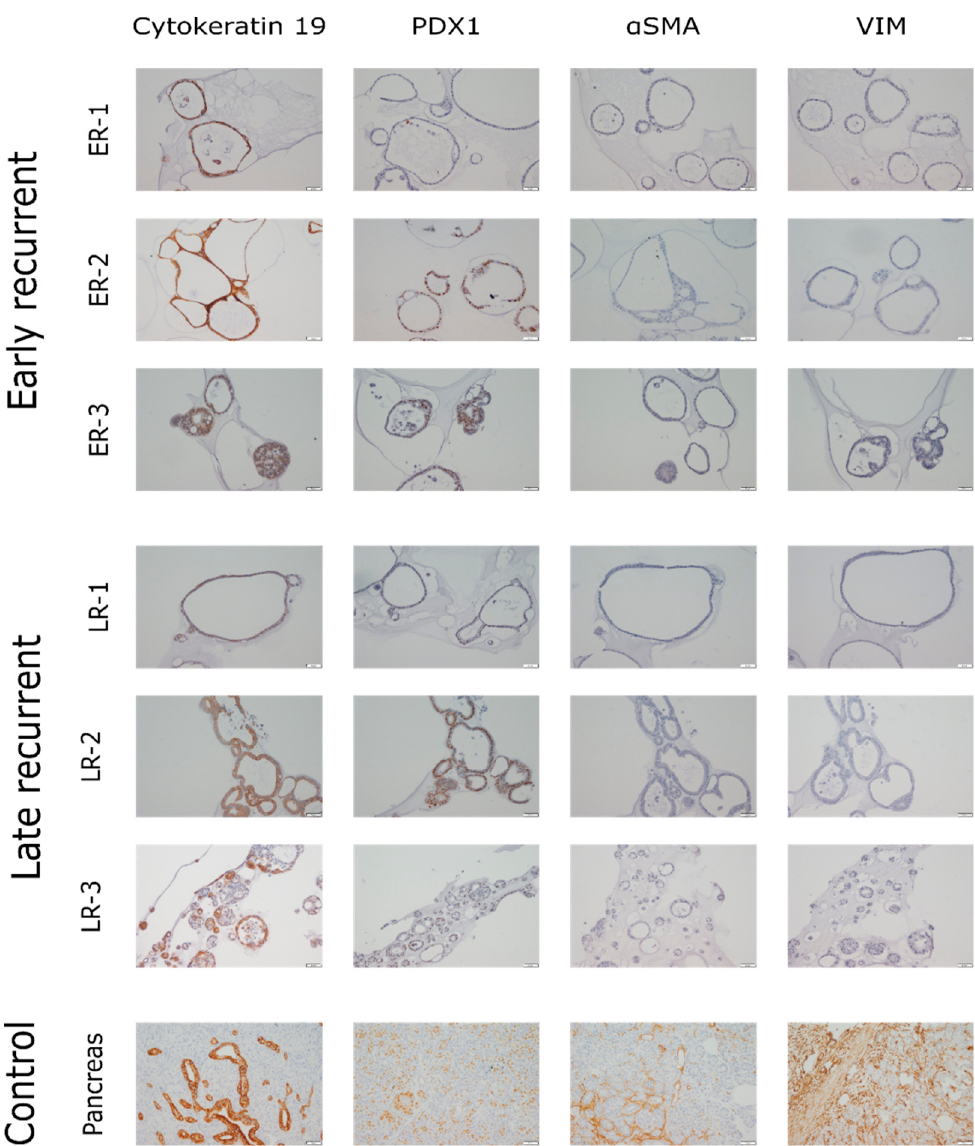
Figure 2. Immunohistochemistry staining of PDOs. Paraffin-embedded organoids were cut into 3 µm sections and stained with antibodies against CK19 (first column) or PDX1 (second column) as markers for epithelial and ductal cells as well as antibodies against α SMA (third column) or vimentin (fourth column) as markers for fibroblasts and mesenchymal cells. Brown color represents a positive signal. Pancreatic tissue served as control. Each panel depicts approximately 500 × 675 µm.